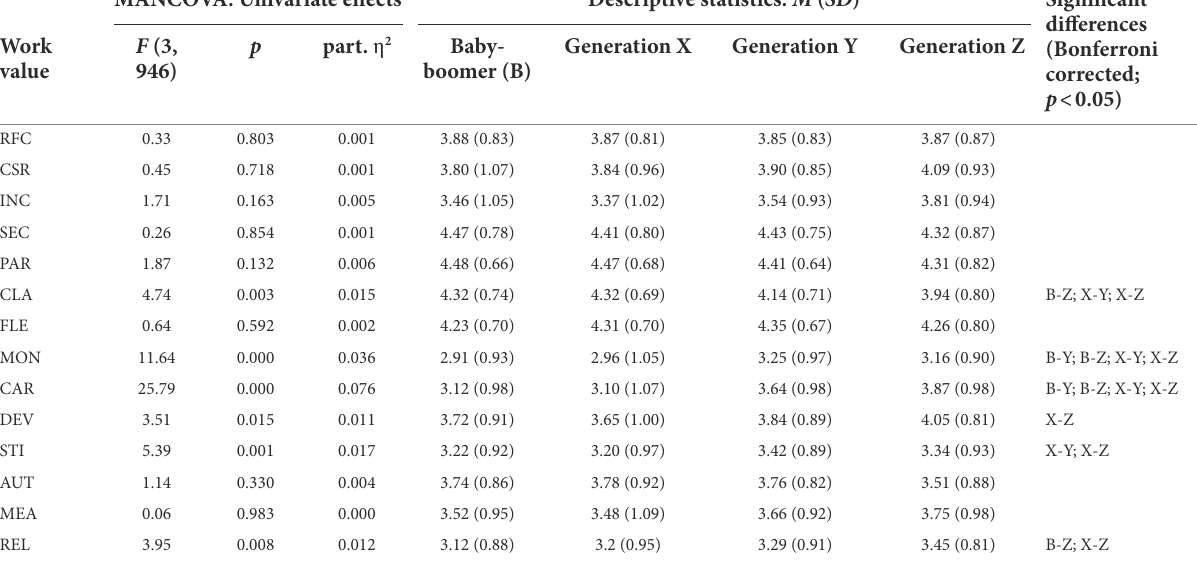
TABLE 3 Generational Differences in Work Values (Univariate